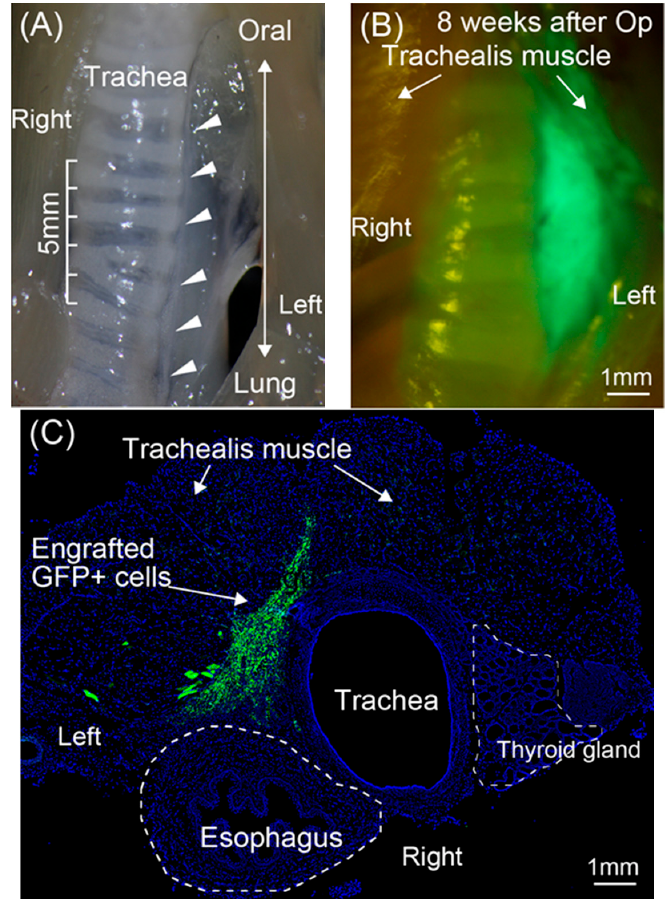
Figure 1. Macroscopic view of recurrent laryngeal nerve (RLN) and macroscopic and histological view of the transplanted Sk-MSCs. ( A ) Macroscopic view of the left RLN and its scale. The RLN runs closely along the trachea (arrowheads). ( B ) Macroscopic view of the engrafted Sk-MSCs transplanted as a hybrid sheet at eight weeks after operation. Green fluorescent protein ( GFP + ) tissues were maintained beside the trachea. ( C ) Histological view of the engrafted skeletal muscle-derived multipotent stem cells (Sk-MSCs) at eight weeks after operation. GFP + cells were also located beside the trachea and esophagus. Blue staining = nuclear staining with 4 ′ ,6-diamidino-2-phenylindole (DAPI). Bars = 1 mm.